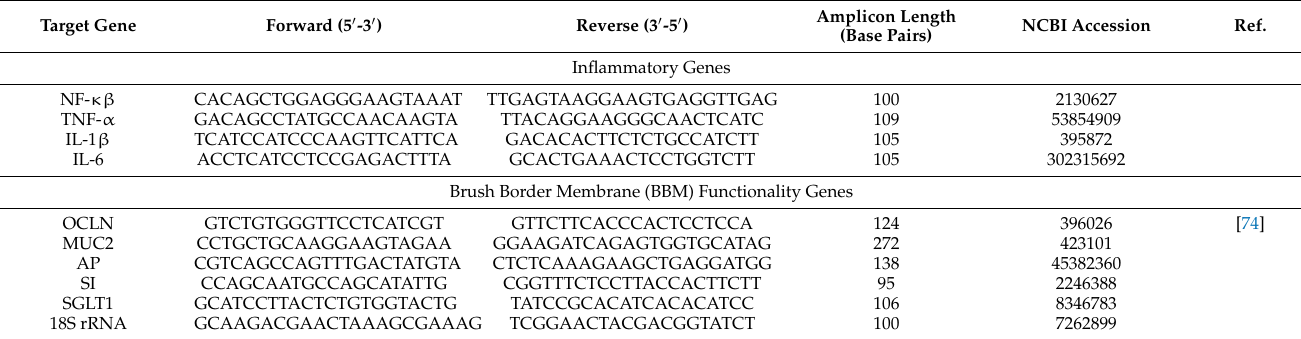
Table 1. Primer sequences used in the